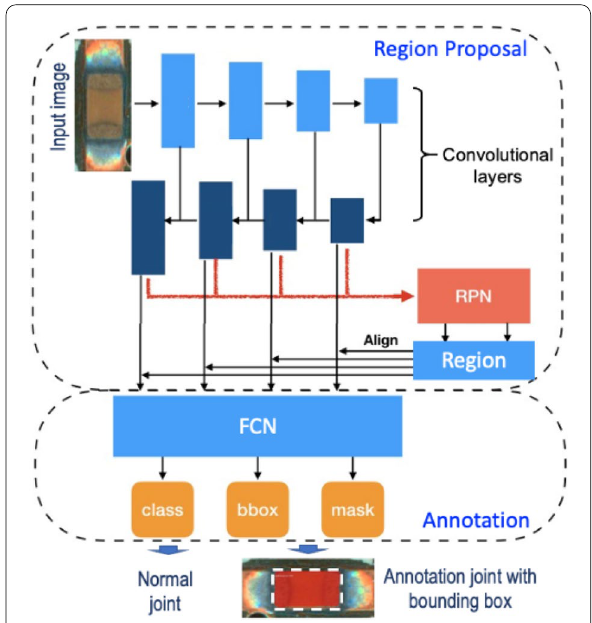
Figure 18 Mask RCNN for solder joint annotation and defect detection, adapted from Ref.